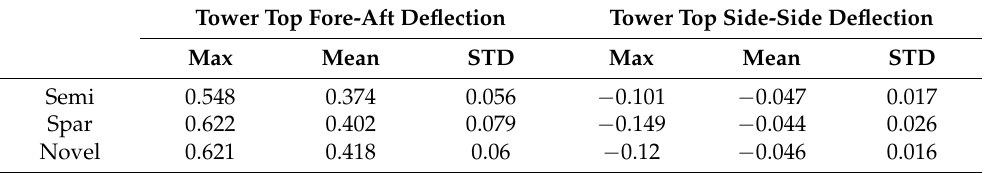
Table 12. Tower top deflection